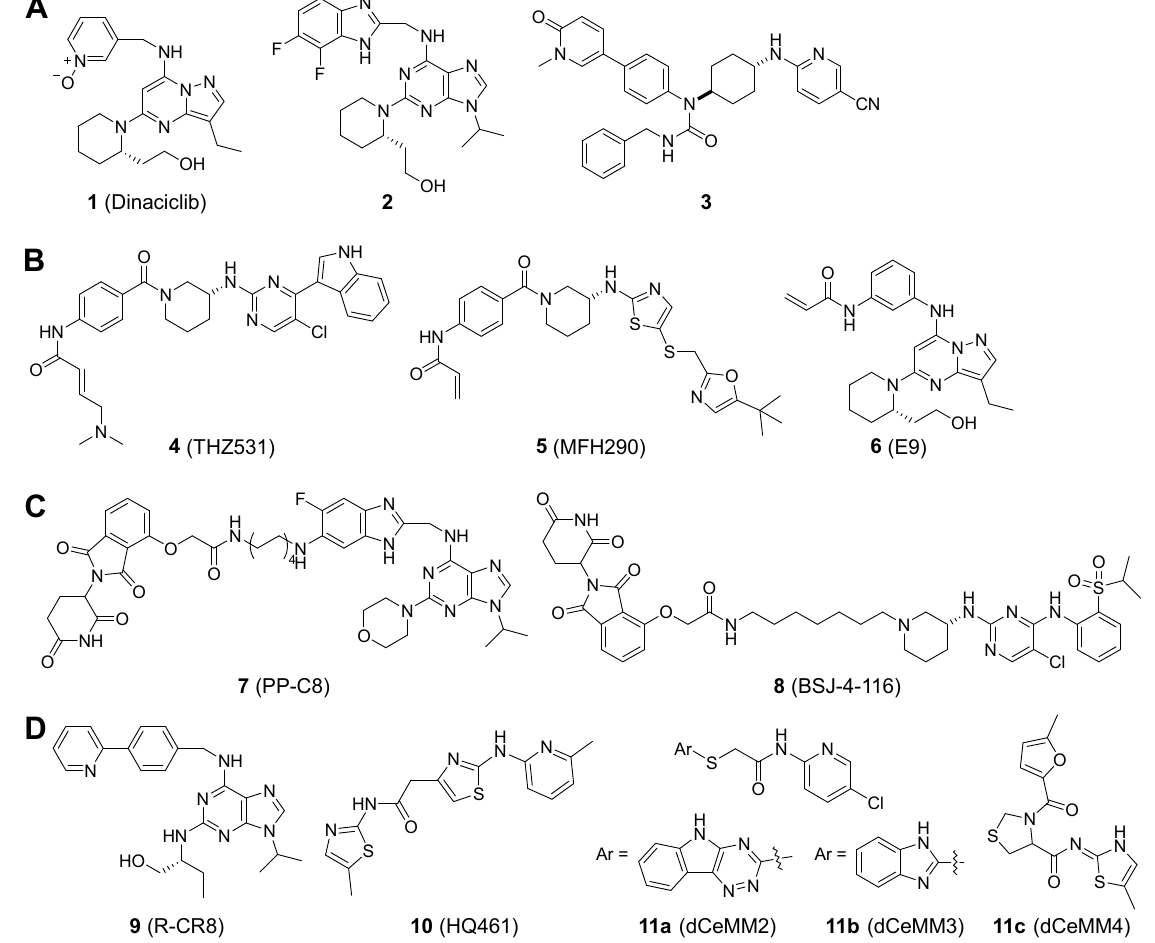
Figure 2. Structures of the published CDK12 inhibitors ( A ) non-covalent CDK12 inhibitors, ( B ) irre- versible CDK12 inhibitors, ( C ) CDK12 inhibitor-based PROTACs, and ( D ) CDK12 inhibitors acting as cyclinK degraders.